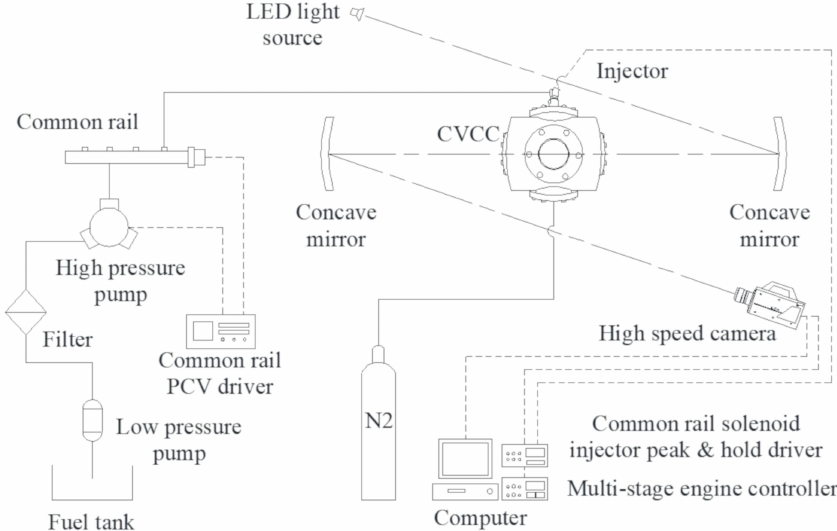
Figure 1. Schematic diagram of the spray image recording system using Schlieren photography technique.